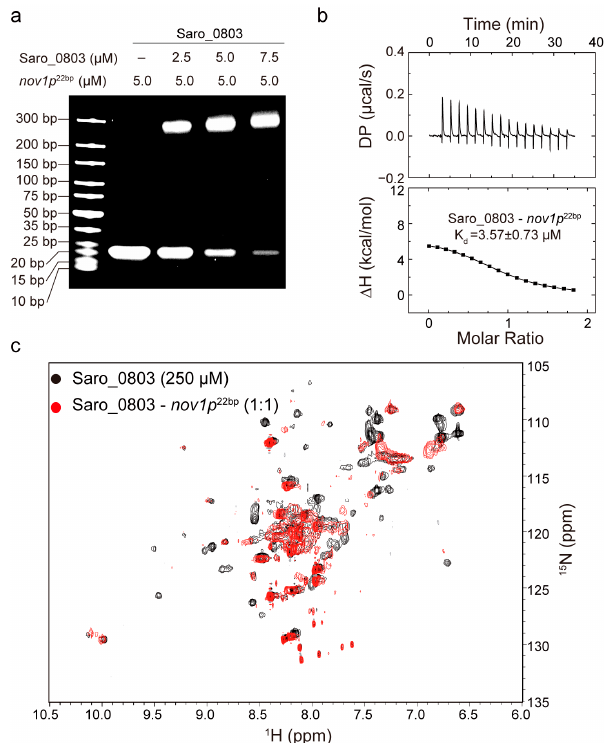
Figure 3. Characterization of the binding capability of Saro_0803 with nov1p 22bp . ( a ) EMSA analysis of the Saro_0803– nov1p 22bp binding ability. Incrementally increased concentrations of Saro_0803 (0, 2.5, 5.0, and 7.5 µM) were incubated with 5.0 µM nov1p 22bp . ( b ) ITC assay with continuous titration of nov1p 22bp . ( c ) NMR titration experiment. Superimposed 2D [ 1 H- 15 N]-HSQC spectra of Saro_0803 in the absence (black) and presence of incubated nov1p 22bp (red).